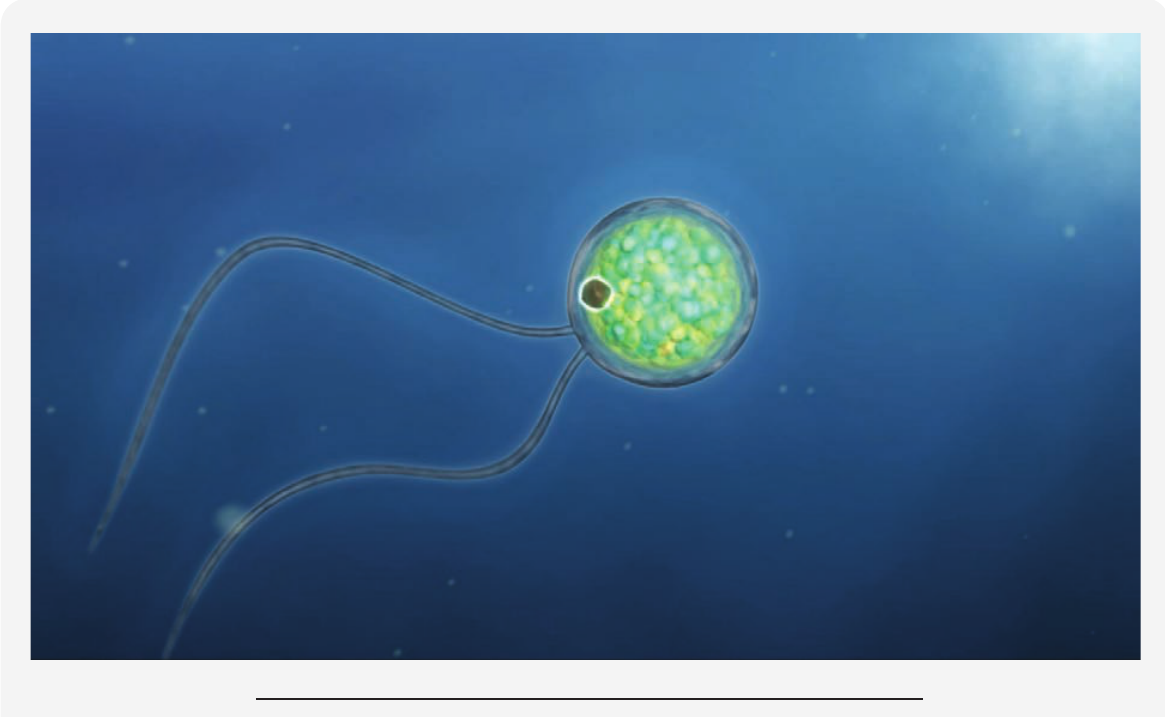
Figure 3. Cartoon of the green alga C. reinhardtii, with the eyespot (brown) highlighted.